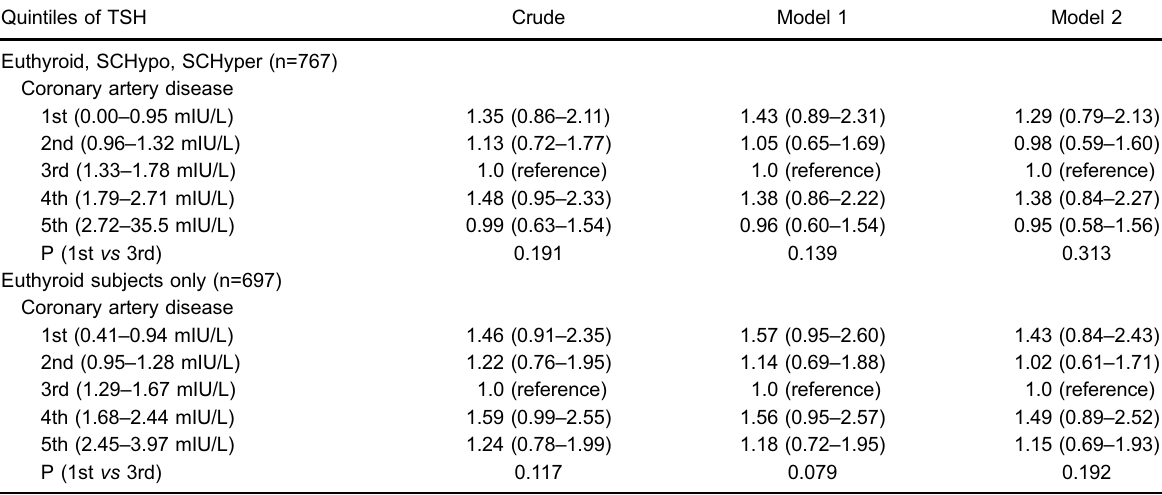
Table 2. Odds ratio and 95% con fi dence interval for associations of coronary artery disease and quintiles of thyrotropin (TSH). Quintiles of